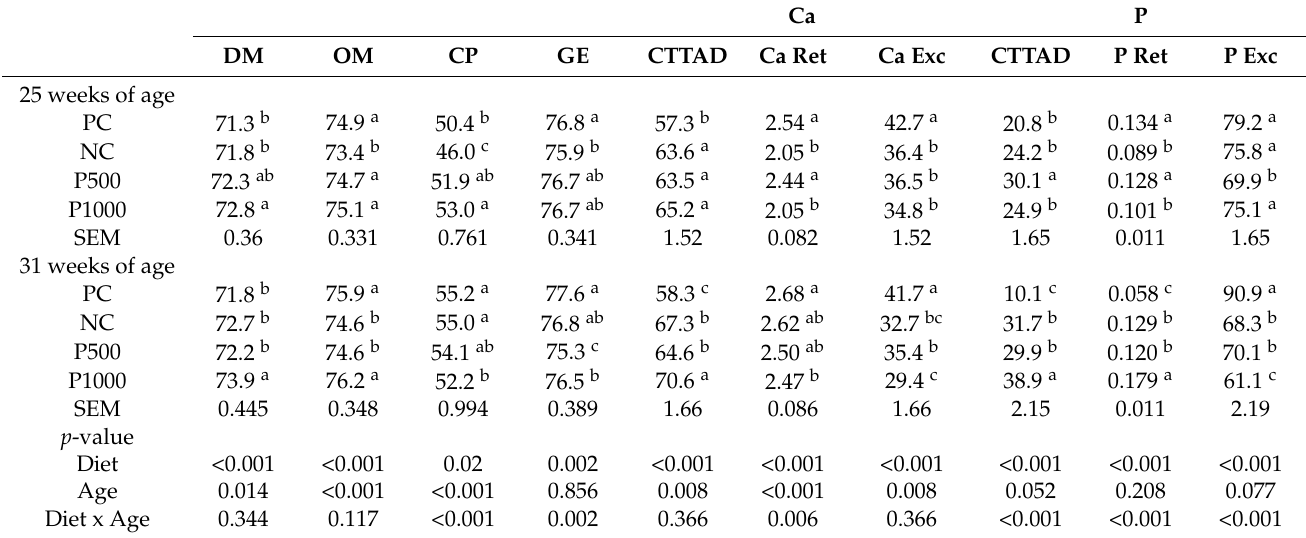
a,b,c Means within a column and age not sharing superscripts differ at p < 0.05. Treatments: PC, positive control; NC, negative control; P500, negative control with phytase at 500 FTU/kg feed and P1000, negative control with phytase at 1000 FTU/kg feed. SEM: standard